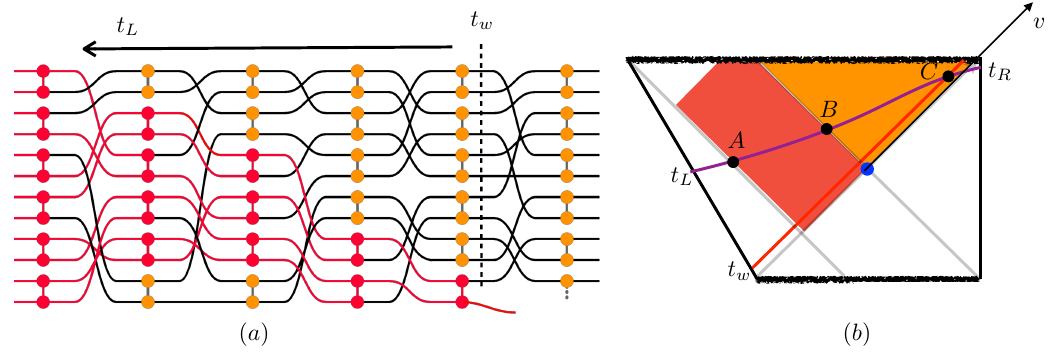
Figure 3 . Illustration of the evolution of healthy and infected gates in (a) compared to the size of the associated bulk regions on time slices in